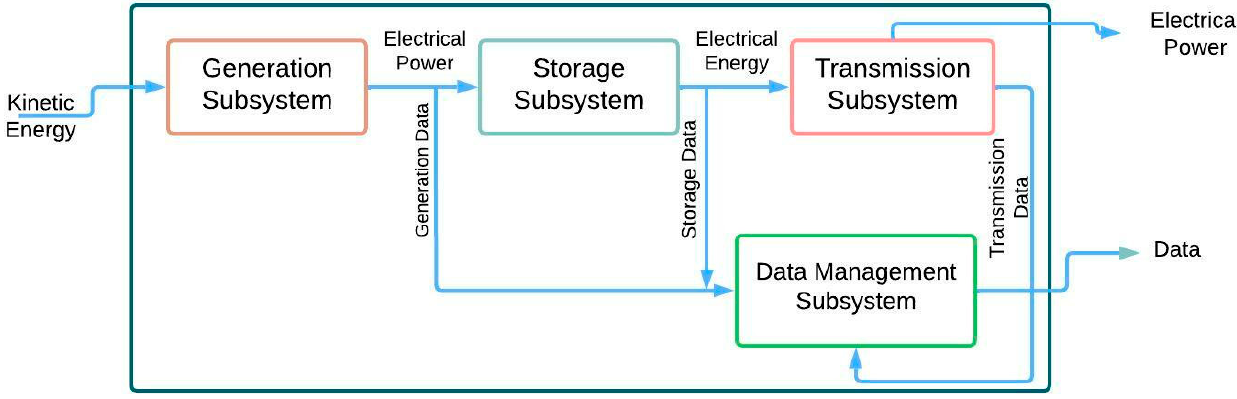
Figure 6. Wireless Charger Utilizing Piezoelectric-Generated Power Diagram.